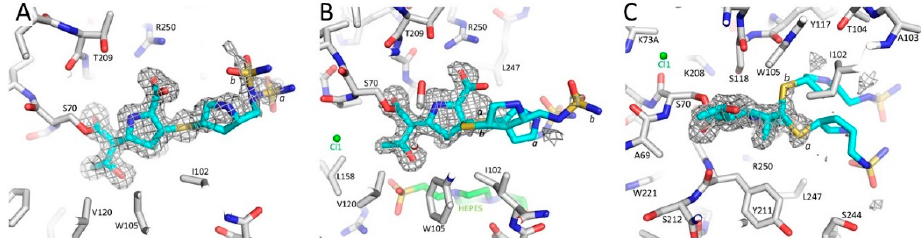
Figure 2. Electron density of doripenem bound in the active site of OXA-48 K73A. ( A ) Unbiased | Fo | - | Fc | electron density di ff erence map of the active site of molecule A of OXA-48 K73 revealing the presence of a covalently bound doripenem (with cyan carbon atoms) attached to S70 (density contoured at 3 σ level). The sulfonamide moiety was observed in two conformations (labeled a and b ). ( B ) Same as in ( A ) but for molecule B of OXA-48 K73A. The tail of doripenem attached to the 2 position of the pyrrolidine ring is observed in two conformations labeled a and b with occupancies of 0.7 and 0.3, respectively (di ff erence density contoured at 2.75 σ level). ( C ) Same as in ( B ) but rotated ~90 ◦ to show the two conformations more clearly.